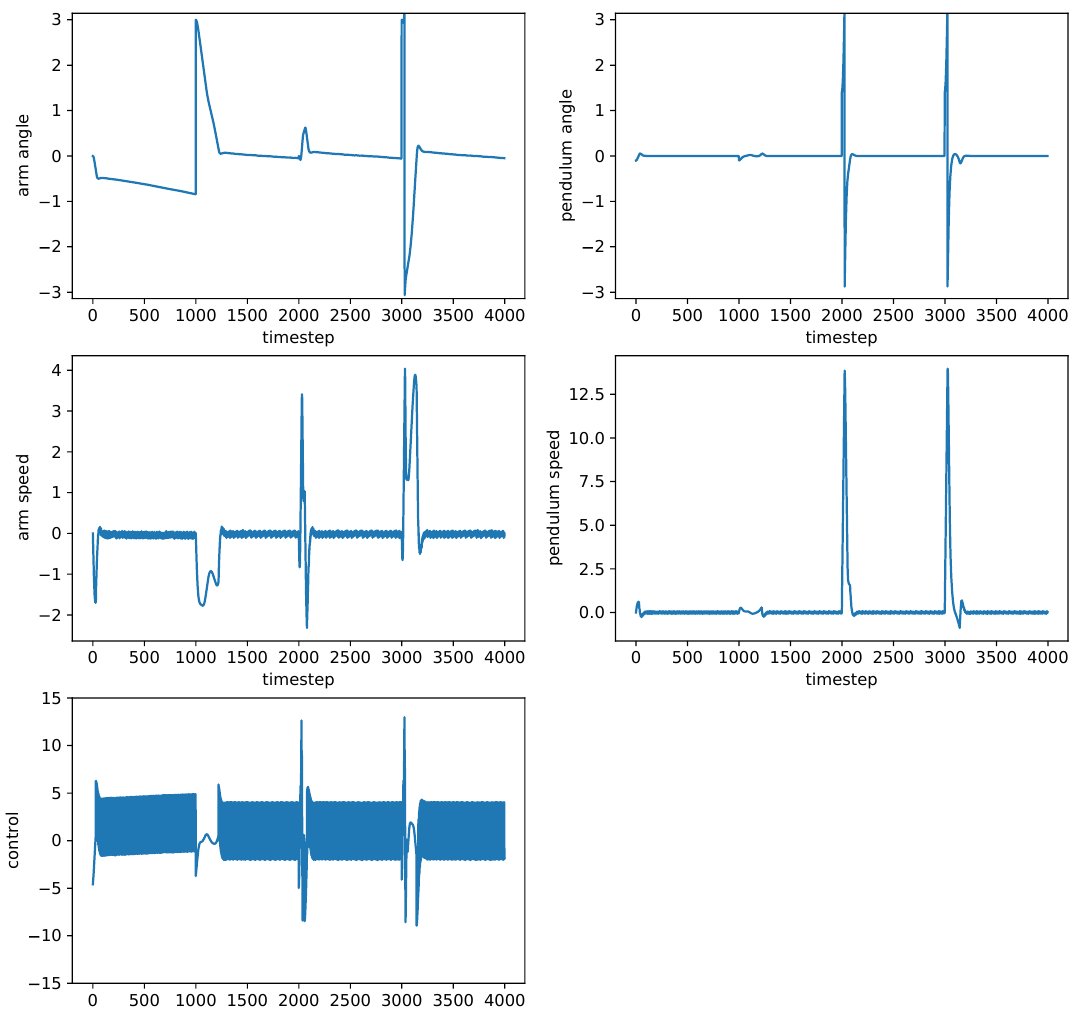
Figure 9. Pendulum dynamics with controller designed by neuroevolution with DBM.